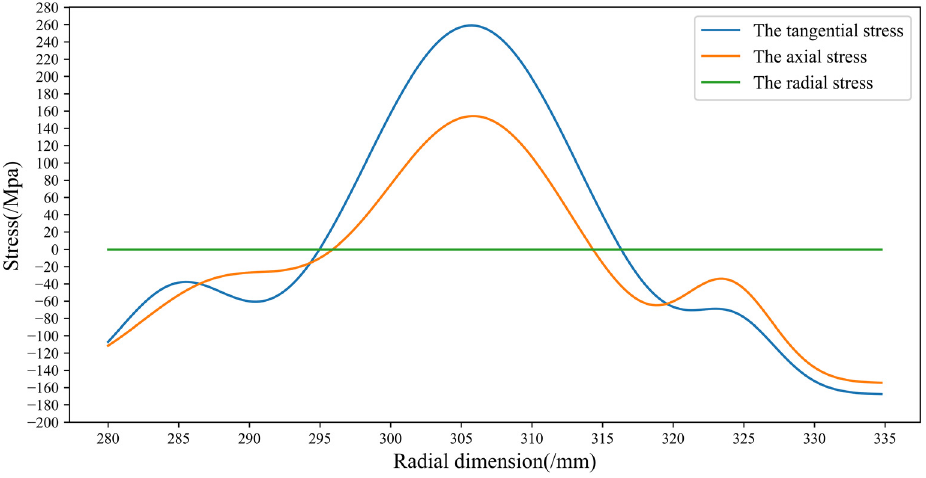
Figure 5. Residual stress distribution.